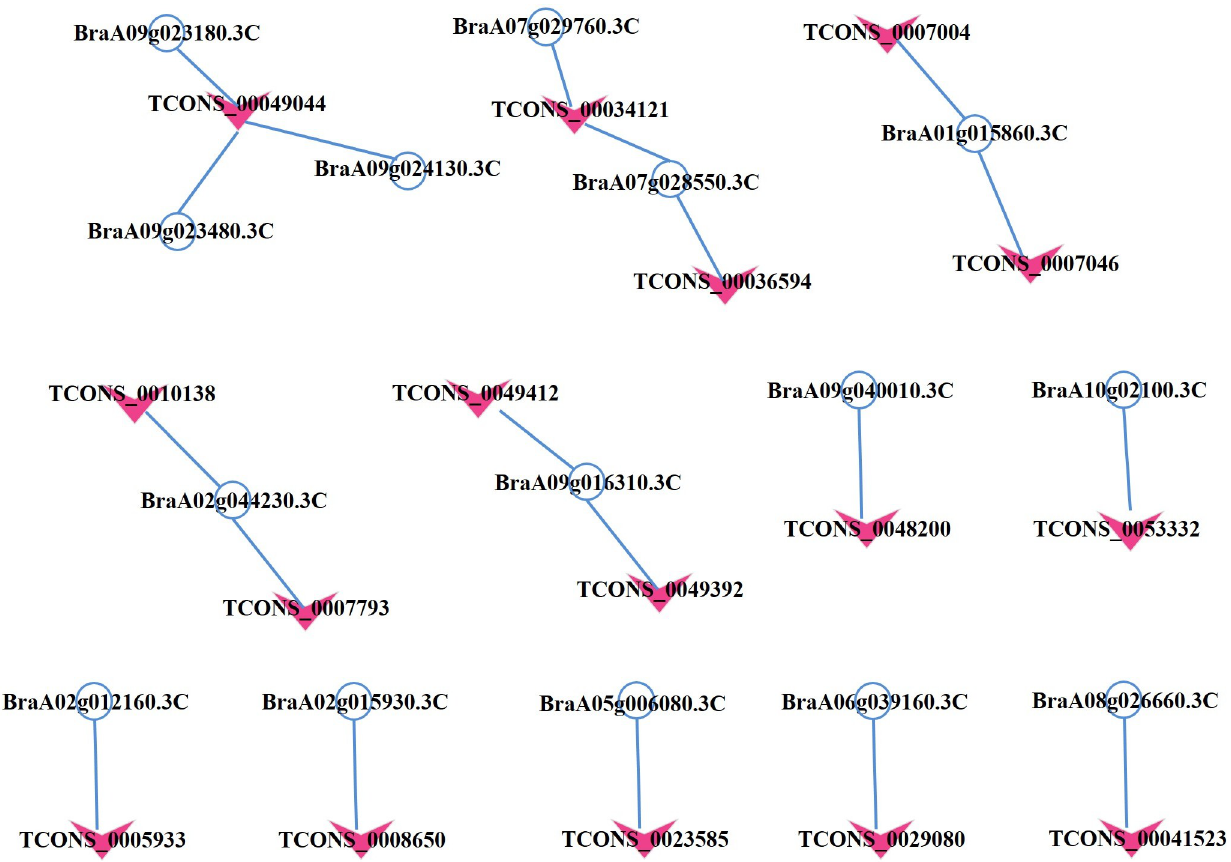
Fig 7. LncRNA-mRNA correlation network of respose to clubroot infection